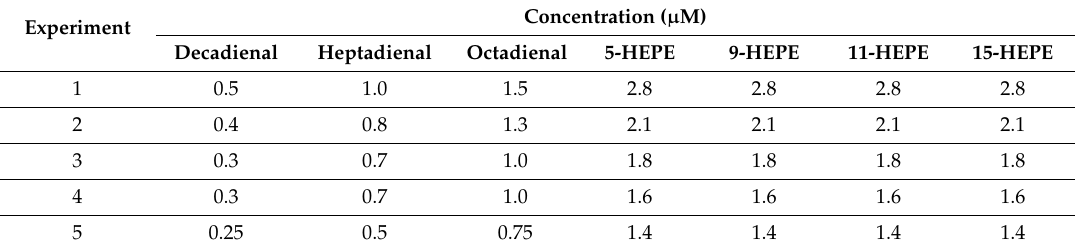
Table 1. Concentrations in micromolar ( µ M) of the seven oxylipins in the five experiments.